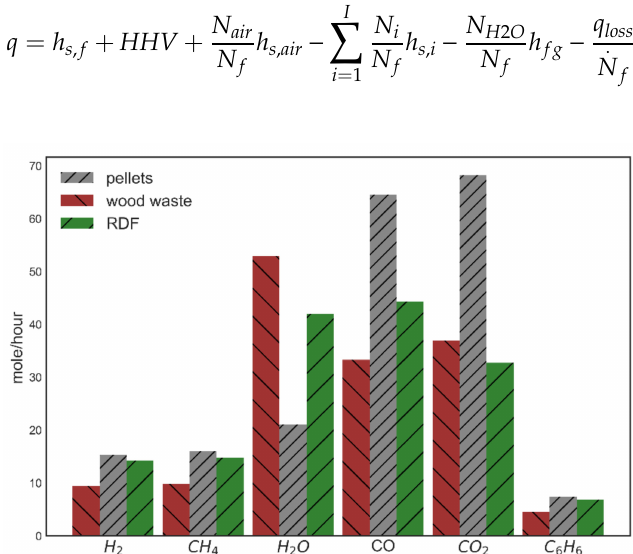
Figure 7. Volumetric concentration of emitting gases from fuel